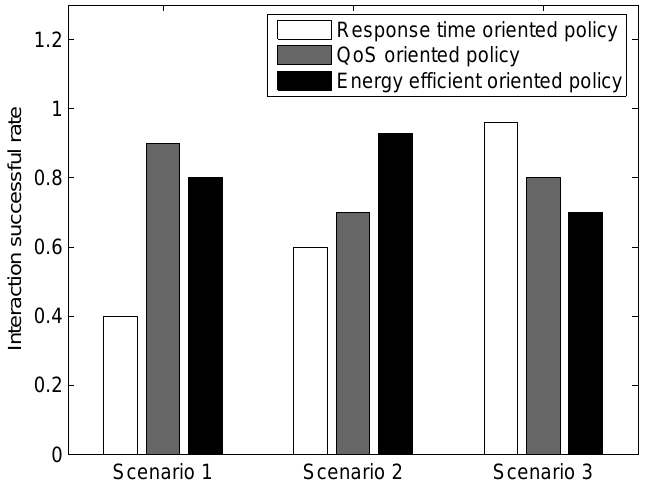
Figure 15. Performance of multi-agent collaborations under three different